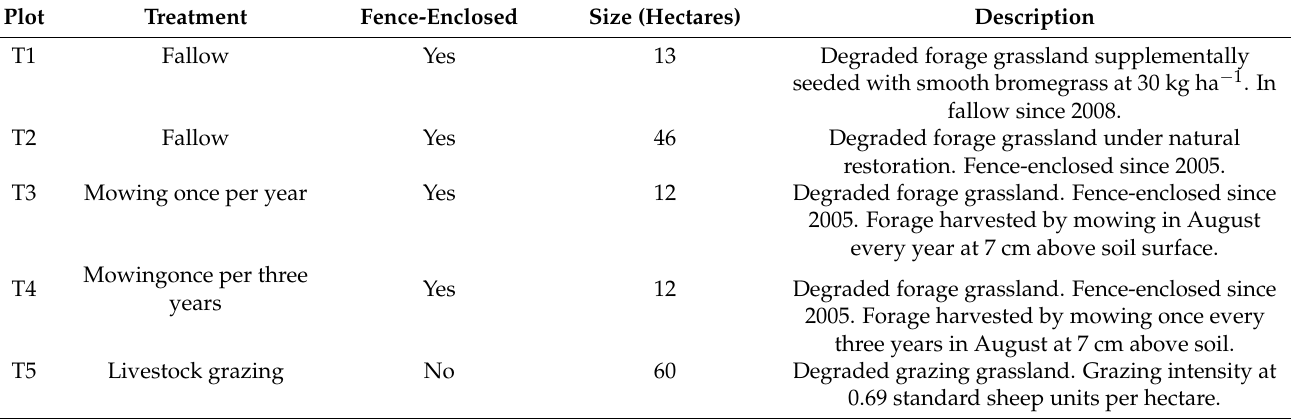
Table 1. Description of the experimental